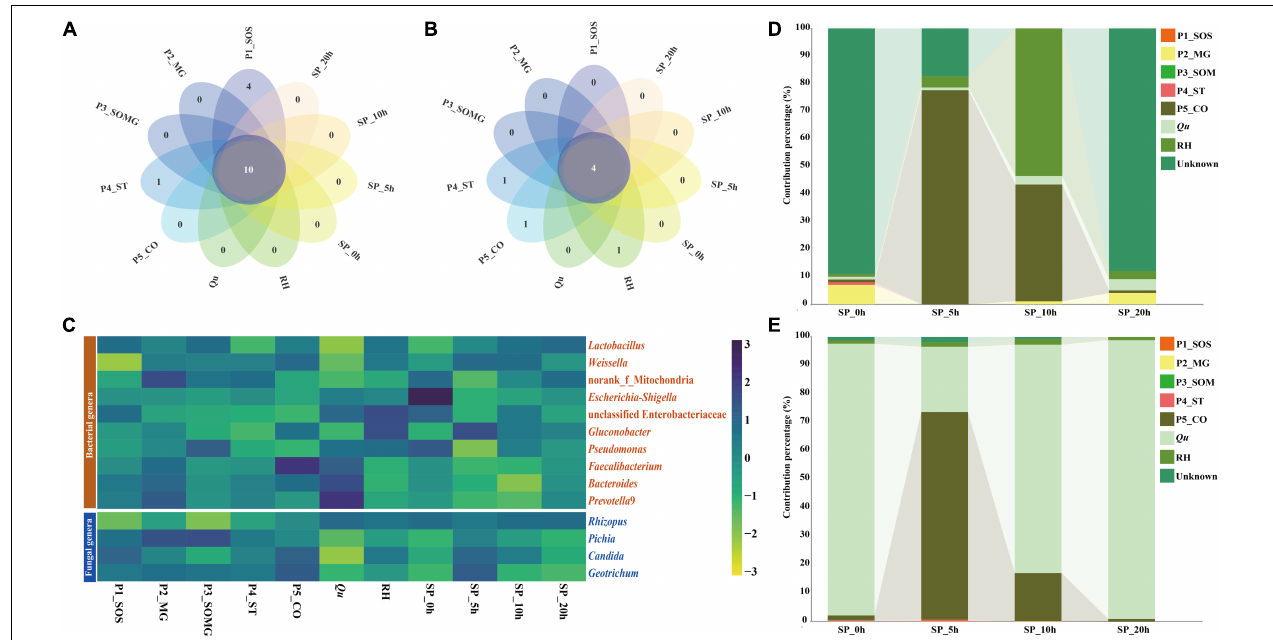
FIGURE 4 | The petal diagram shows the unique and shared bacterial (A) and fungal genera (B) among different samples. The heat map shows the relative abundance of the microbial genera shared in all samples (C) . Sourcetracker results highlight the contribution percentages of the source bacterial (D) and fungal (E) community in the pretreatment stage to the saccharification